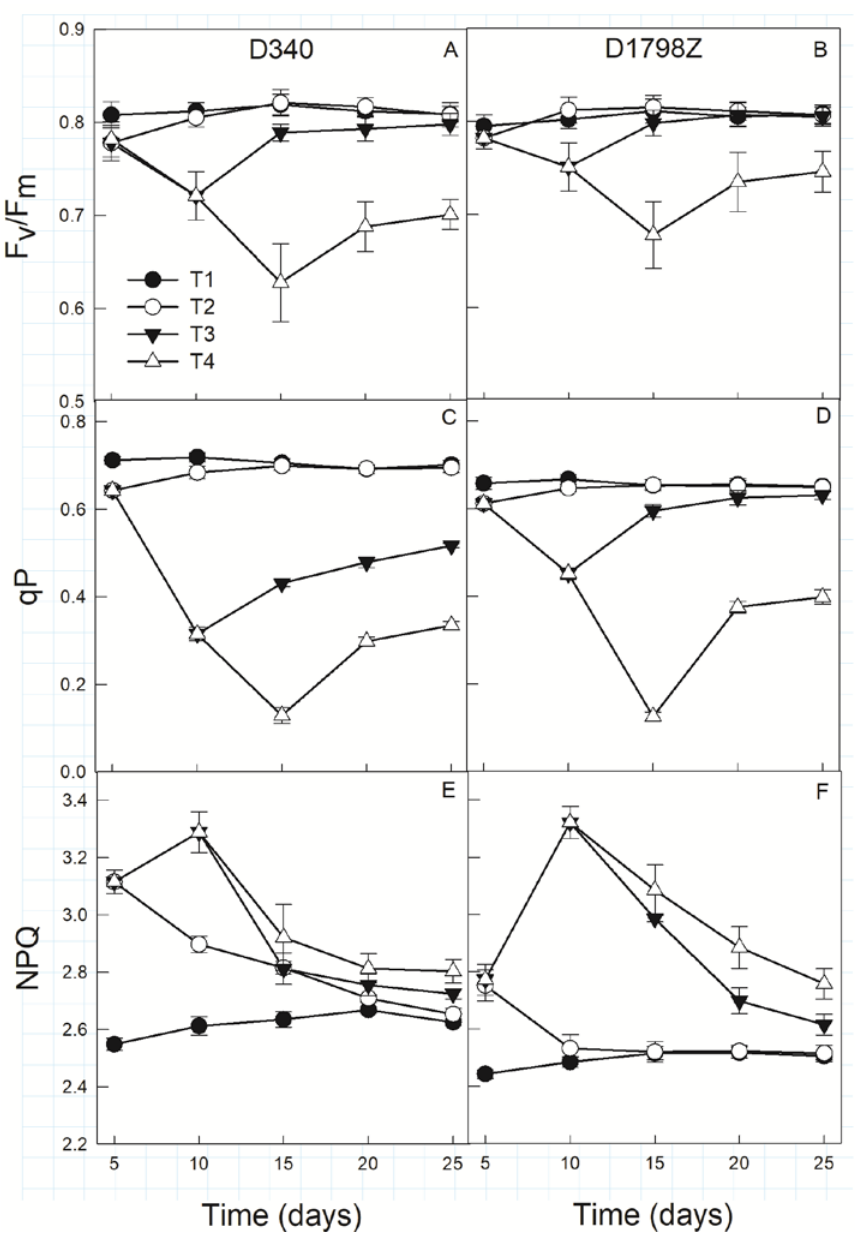
Figure 4. Effect of different drought durations and re-watering on Fv/Fm, maximum quantum Figure 4. E ff ect of di ff erent drought durations and re-watering on Fv / Fm, maximum quantum e ffi ciency efficiency of PSII (photosystem II) ( A – B ), qP, photochemical quenching ( C – D ), and NPQ, non- of PSII (photosystem II) ( A , B ), qP, photochemical quenching ( C , D ), and NPQ,